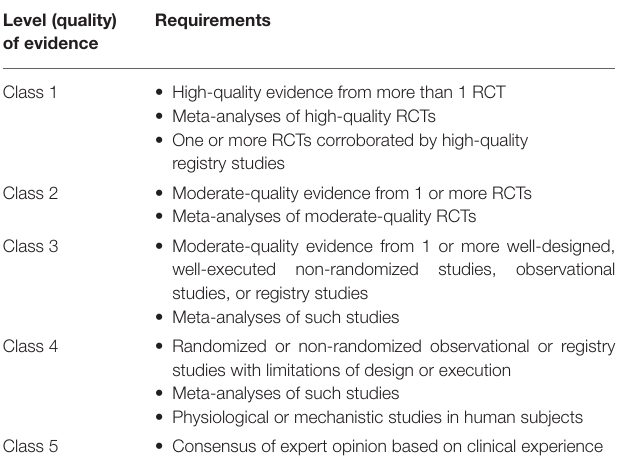
TABLE 1 | Level of evidence.